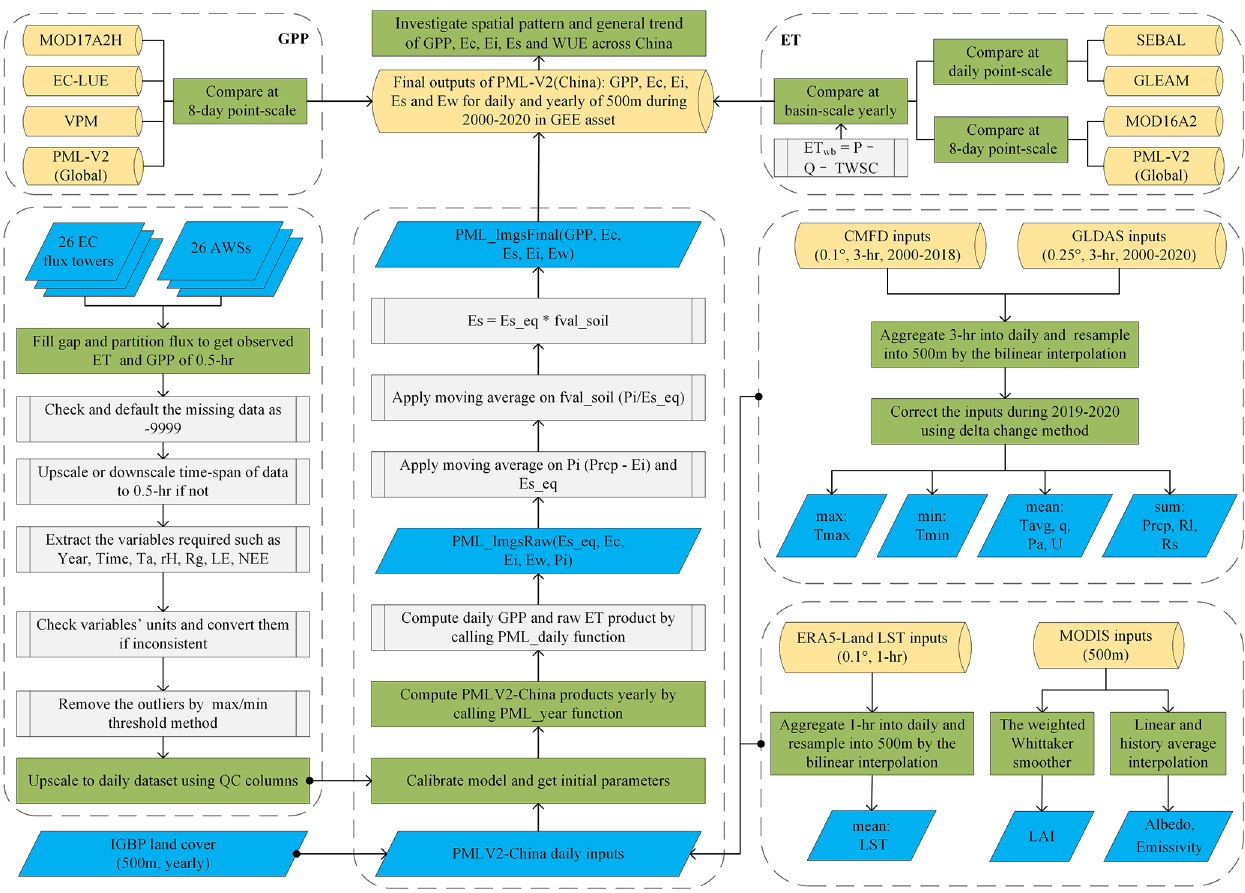
Figure 1. Flowchart of EC flux and AWS data pre-processing and PML-V2 model processing which is used to convert RS images and meteorological forcing images into GPP, E c , E i , E s , E w , and ET. For the pre-processing part: NEE (net ecosystem exchange, µmolm − 2 s − 1 ), LE (latent heat, Wm − 2 ), Rg (incoming radiation, Wm − 2 ), rH (relative humidity, %), T a (air temperature, ◦ C), and QC (quality control). For the PML-V2 model part: T max (daily maximum temperature, ◦ C), T min (daily minimum temperature, ◦ C), T avg (daily mean temperature, ◦ C), Pa (atmosphere pressure, kPa), U (wind speed at 10m height, ms − 1 ), q (specific humidity, kgkg − 1 ), Prcp (precipitation, mmd − 1